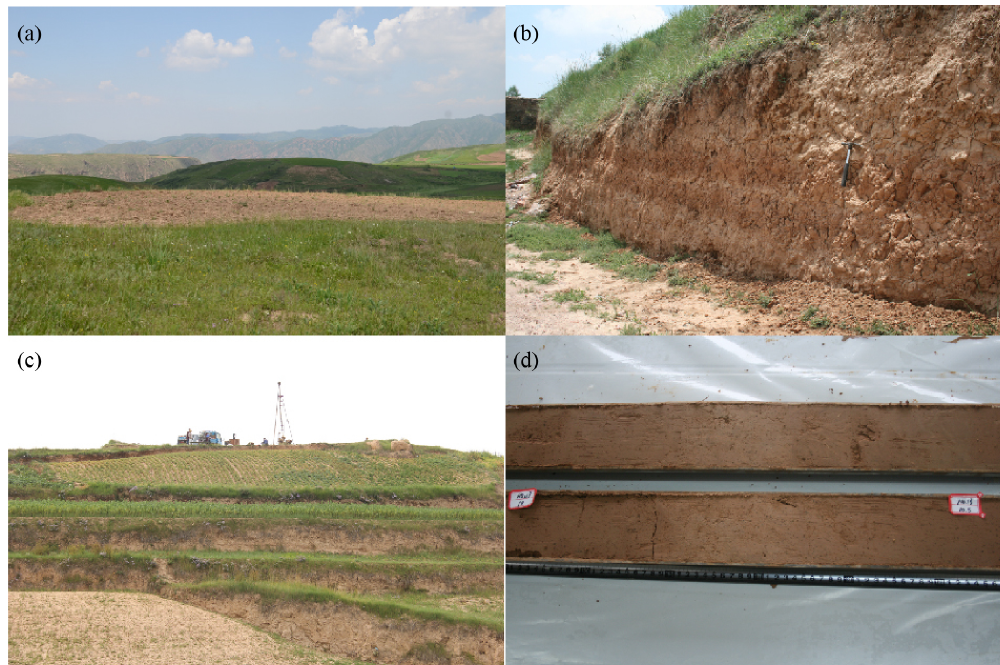
Figure 2. Photos of the XSZ planation surface and the red clay. (a) XSZ planation surface. (b) Red clay outcrop, XSZ. (c) Position of the XSZ drill hole. (d) The XSZ drill core.